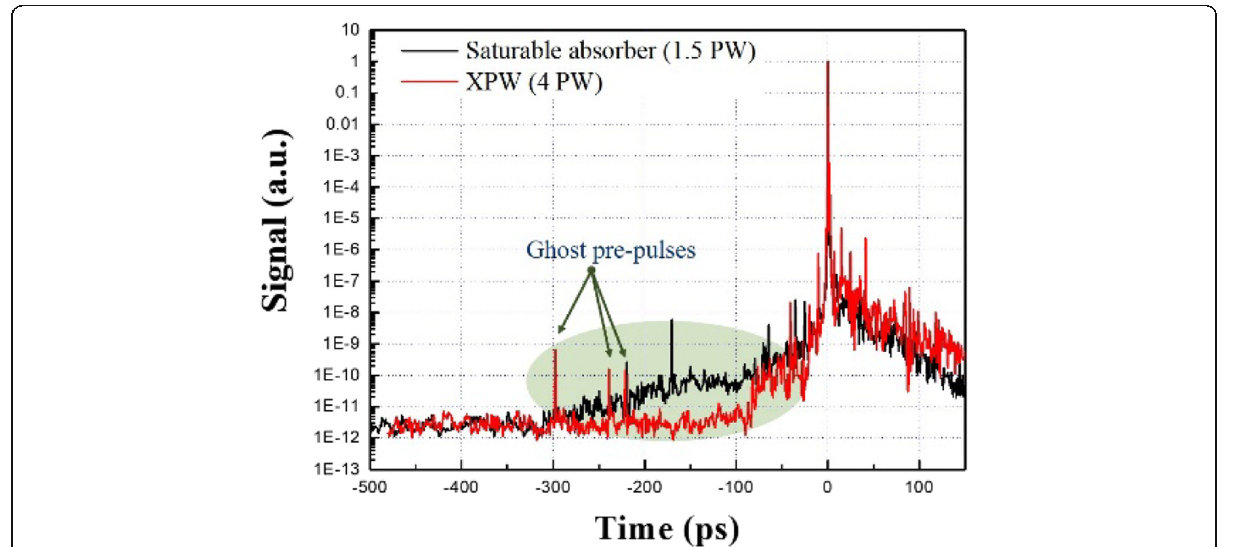
Fig. 7 Temporal contrasts of the ultra-high intensity lasers at CoReLS. The 30 fs, 1.5 PW laser employed saturable absorbers in the frontend, while the 20-fs 4-PW laser adopted an XPW